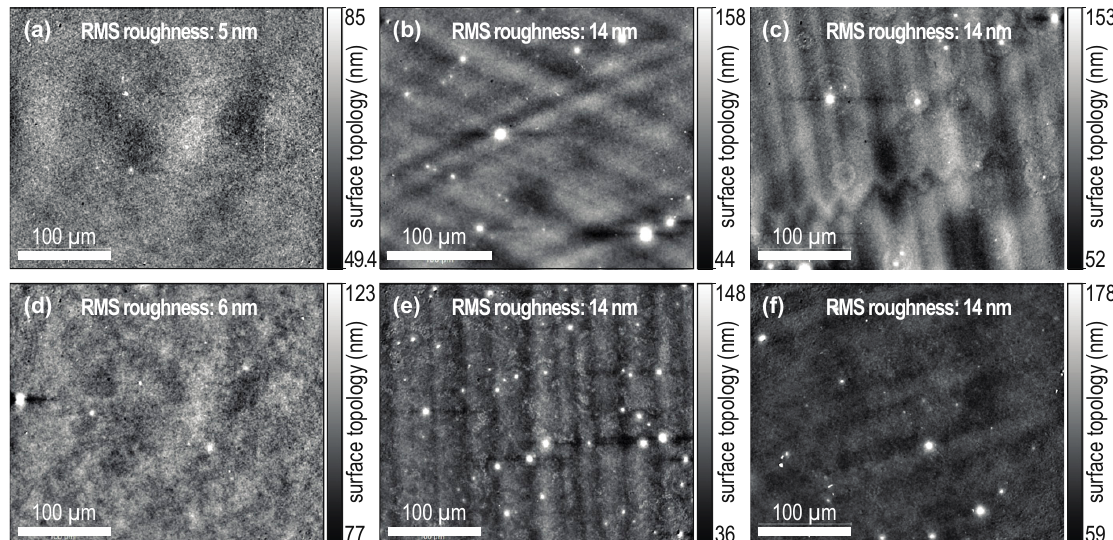
Figure A5. Topography of the BPFMO films deposited on LAO substrate revealed by optical profilometry for the different Pr substitution concentrations: ( a ) 5%, ( b ) 10%, ( c ) 12.5%, ( d ) 15%, ( e ) 17.5%, and ( f ) 20%. The color bar stands for the surface topography and the associated root-mean-square (RMS) surface roughness is given in each case.